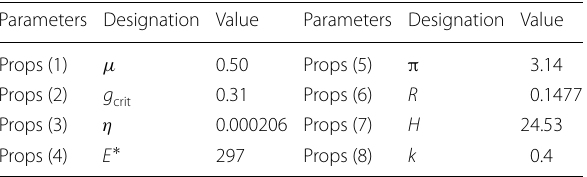
Table 3 The parameters used for normal contact model subroutine